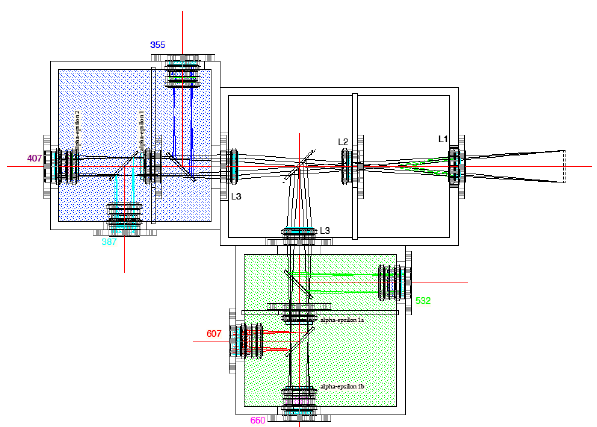
Fig. 13. Schematic view of the optical ensemble of the future lidar Figure 13. Schematic view of the optical ensemble of the future lidar implemented at 3 implemented at Observatoire de Physique de l’Atmosph`ere de La Observatoire de Physique de l’Atmosphère de La Réunion (OPAR). 4 R´eunion